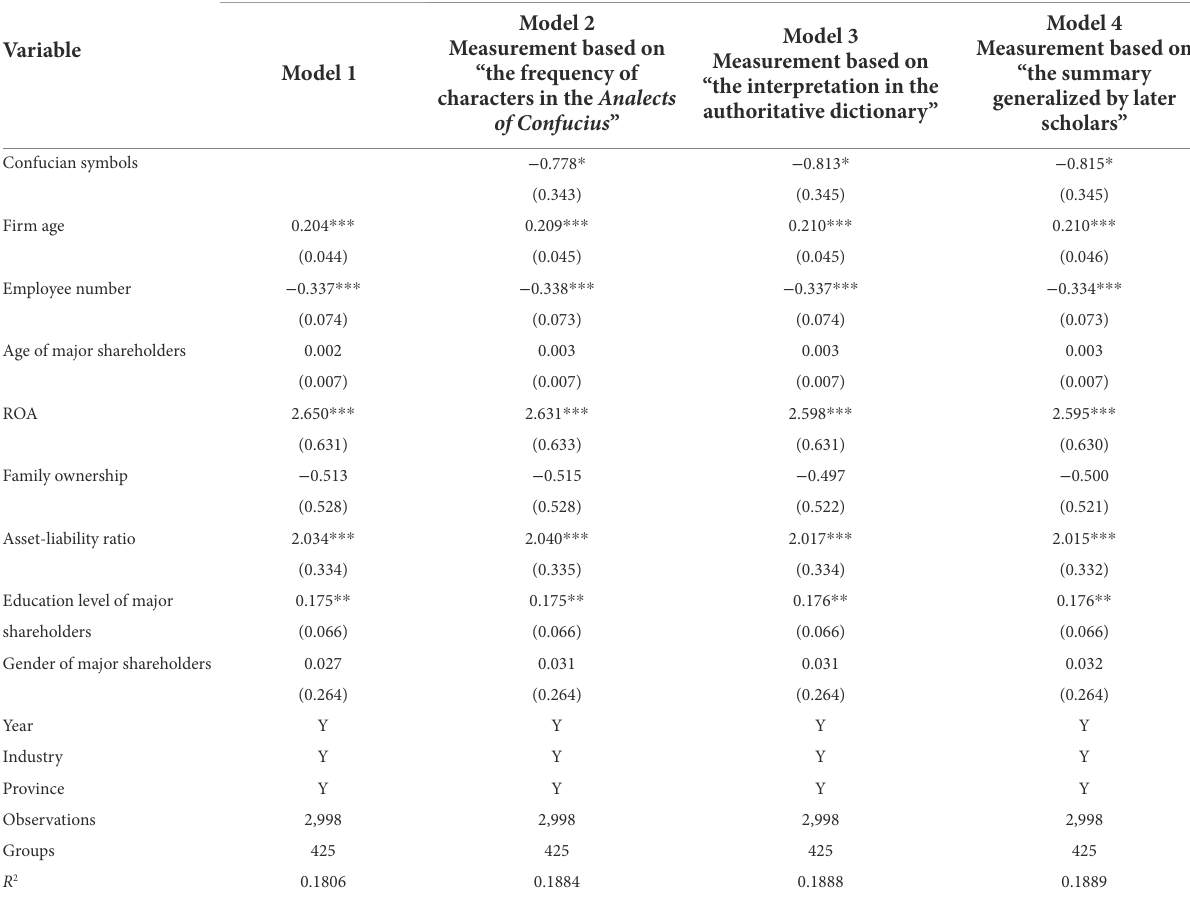
TABLE 2 The effect of Confucian symbols on misappropriation of corporate assets.